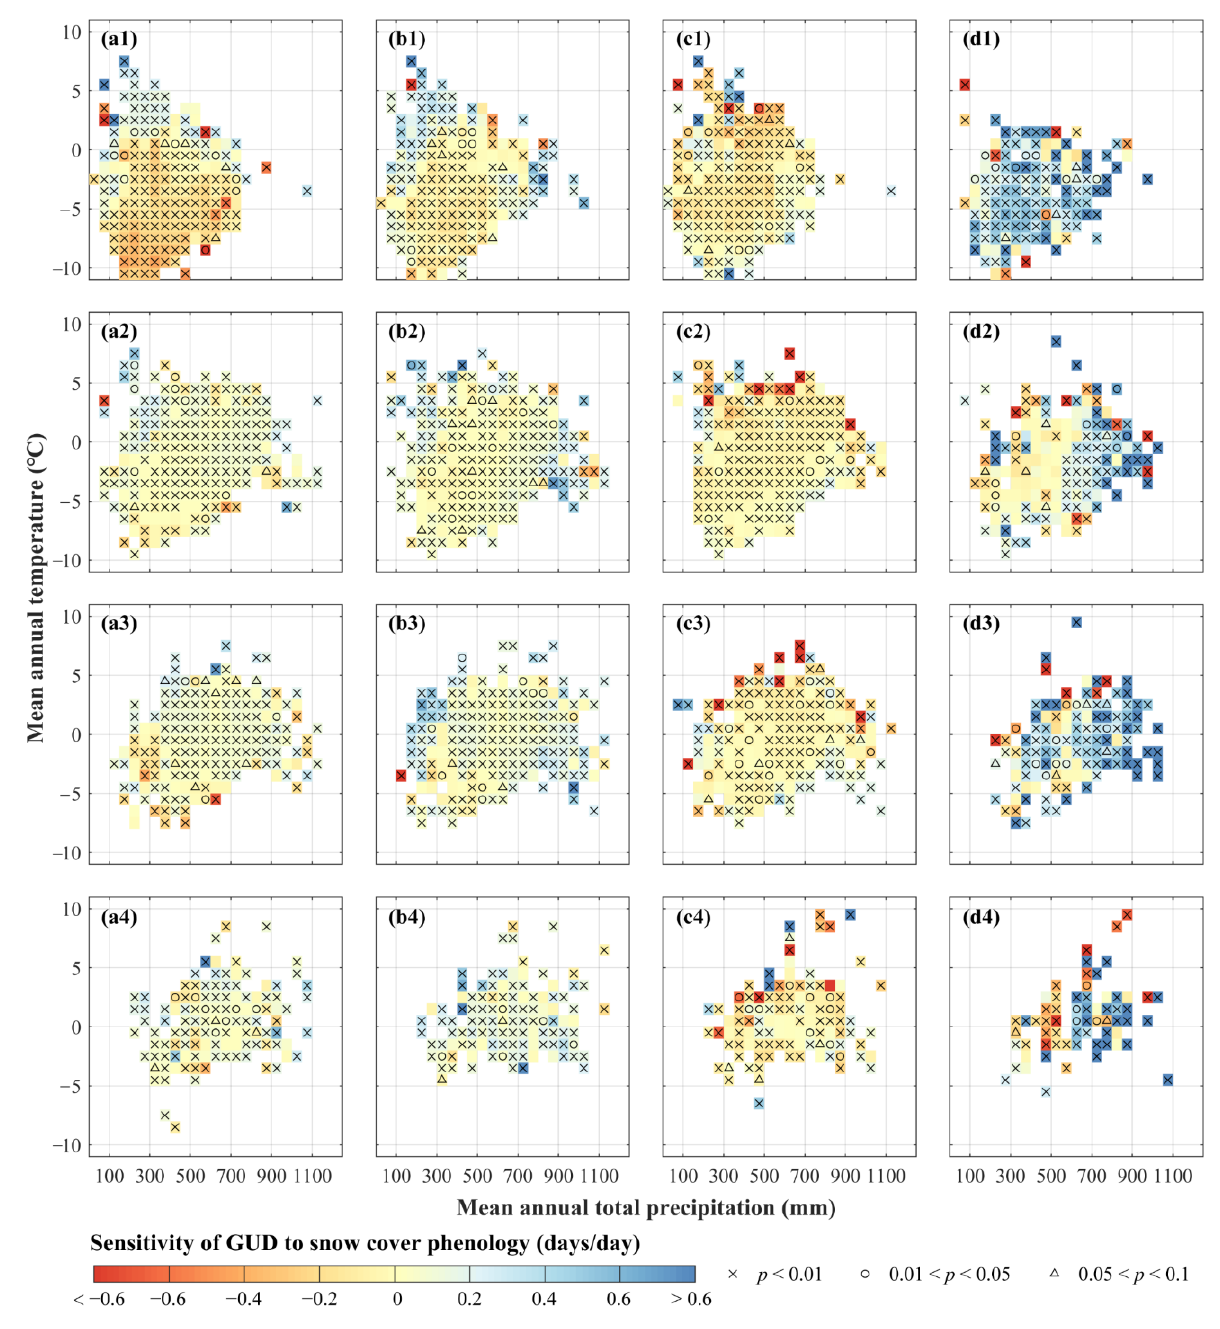
Figure 9. Variations in GUD sensitivity to the snow cover phenology for the pixels with a significant correlation ( p < 0.01) in the four vegetation types along temperature and precipitation gradients. The letters ( a – d ) represent the sensitivities of GUD to SCOD, SCED, SCD, and SMOD, respectively. The numbers 1 – 4 represent steppe, meadow, shrub, and forest, respectively.